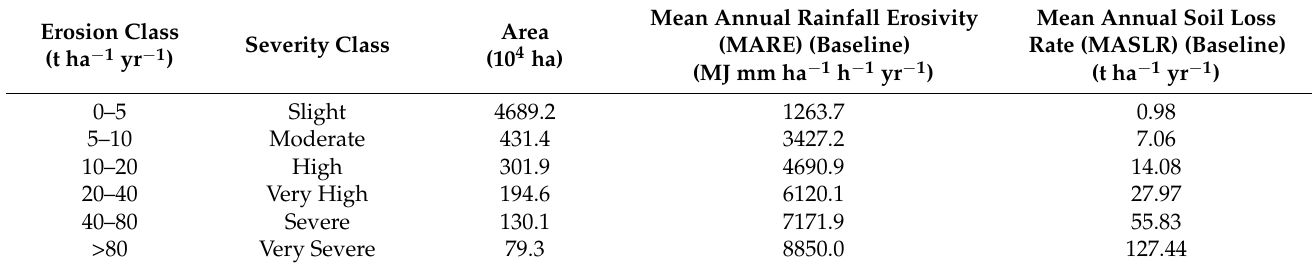
Table 4. Baseline soil erosion rates per severity classes in Kenya.